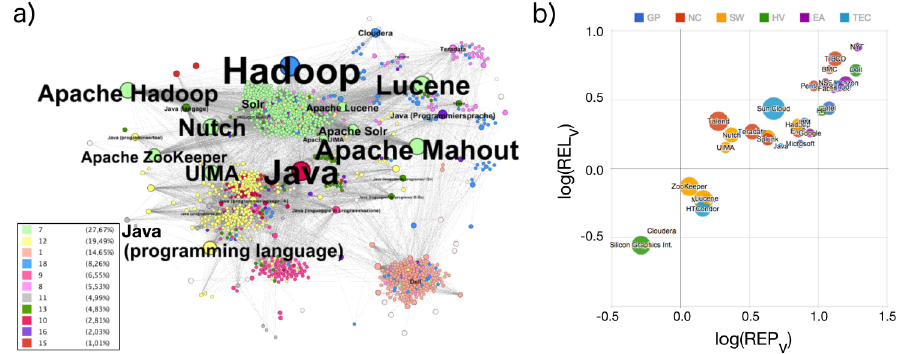
Fig 2. (a) Wikipedia network representation for several interconnected local networks (several CNs with their LNs). The selected topics are related to the emerging Hadoop market, see Table 1 in section 2.1 for details. The colors indicate the membership of the nodes to topical clusters (see legend). Wikipedia pages about Hadoop-related projects are found in close neighborhood of new companies and also close to two important programming languages, Java, and C++, which have both been highly recognized for many years. All CNs with less then five links ( k = | LN | < 5) have been removed as the layout was calculated with Gephi (OpenOrd layout). (b) Representation and relevance plot showing text volume REL v versus REP v with circle sizes given by logREP k for all selected CNs as in (a). Colors indicate the role of each group in the emerging Hadoop market and differ from modularity classes used in 2a. One can see a high text volume representation index for pages about the early adopters of Hadoop technology (EA, purple). Wikipedia pages about core technology, which is software such as Apache Lucene, Apache Nutch, and Apache Mahout (SW, orange) have a low relevance index REL v . Their representation index REP v is also small compared with the companies that use the new technology. The label (HV, green) stands for Hadoop-related hardware vendors, (TEC, light blue) for general technology companies, (GP, blue) for global players, and (NC, red) for the competitors within the emerging